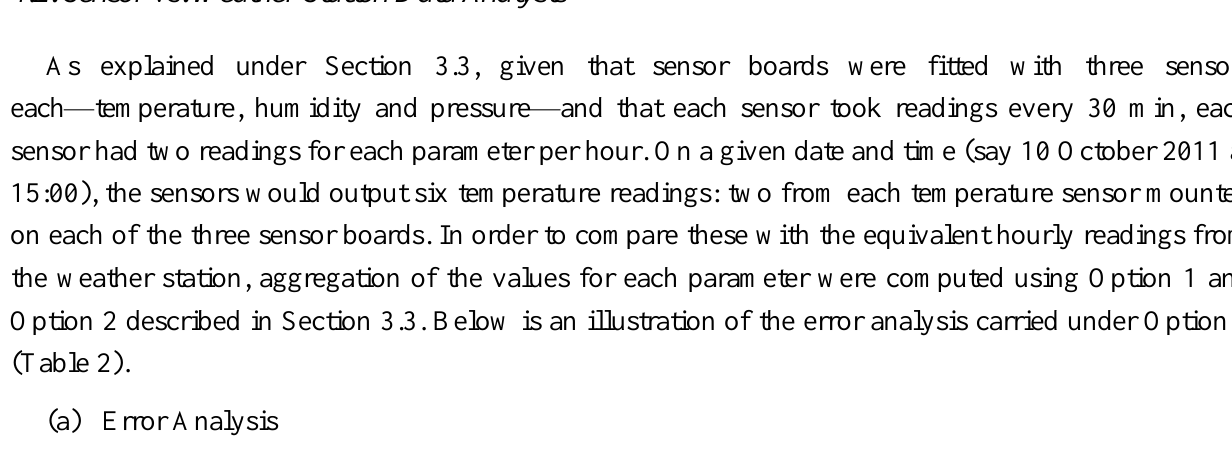
Table 2. Comparison of Option 1 error